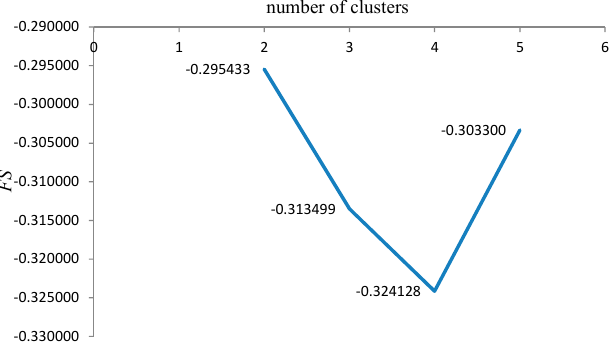
Figure 6. Graph of the Fukuyama-Sugeno validity functional for a (78 × 4) matrix.